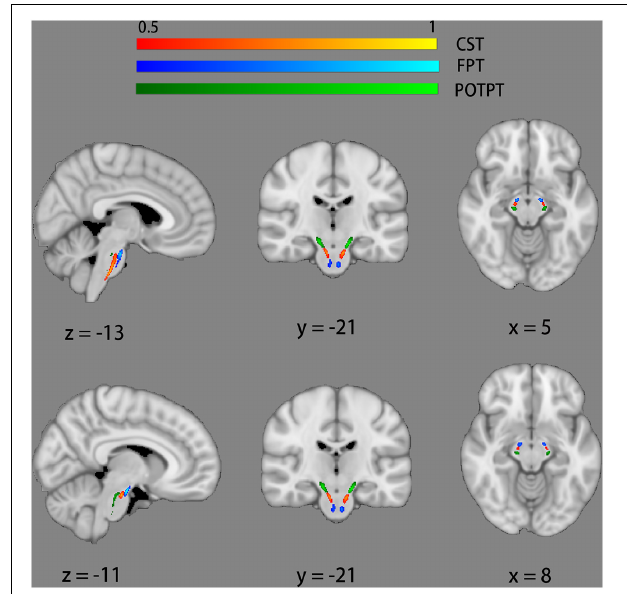
FIGURE 1 | Six regions of interest of motor tracts defined by probabilistic atlases of 23 brainstem bundles. The bilateral corticospinal tracts (CST) are marked red-yellow. The bilateral fronto-pontine tracts (FPT) are displayed in blue. The bilateral parieto-occipito-temporo-pontine tracts (POTPT) are represented as